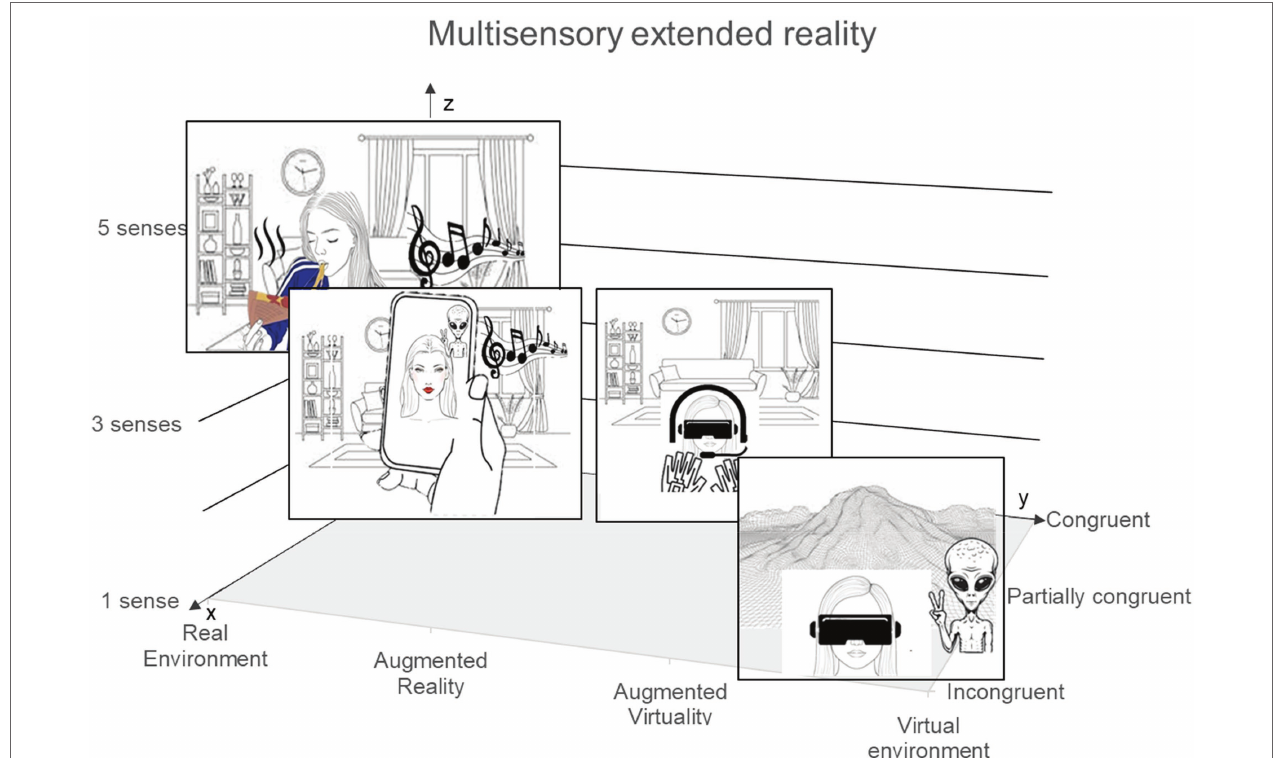
FIGURE 1 | Multisensory XR including (1) the reality-virtuality continuum from Milgram and Kishino (1994), enhanced by (2) sensory inputs, and considering (3) their level of congruency with the environment. By considering this multisensory XR model, marketers can potentially stimulate one or more of the consumer’s senses (e.g. 1: vision, 3: vision, audition and touch, z-axis), from the real-life, real and virtual or only virtual environment (e.g. vision: virtual, audition: real, y-axis) and make these stimulations incongruent, partially congruent or completely congruent with the real-life environment and/or virtual environment (e.g. virtual alien through the smartphone in the physical living room with the noise of the television in the background,